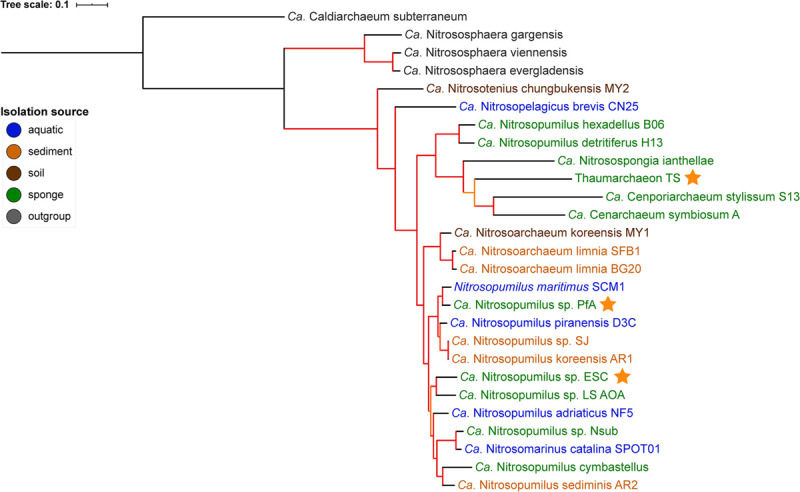
Phylogenomic tree of free-living and sponge-associated Thaumarchaeota. Origin is indicated by font color. Genomes obtained in this study are indicated by an orange star. The tree was calculated using maximum likelihood with the PROTCATLG model of evolution and is based on 182 single copy marker genes (see “Materials and Methods” section for details). Branch colors indicate bootstrap support based on 1,000 repetitions: orange 87–89%, red > 97%. The tree was rooted with Ca. Caldiarchaeum subterraneaum (black branch).